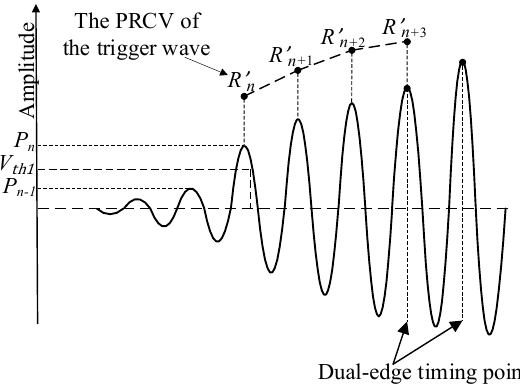
Figure 9. The PRCV of the trigger wave and the wave at the dual-edge timing point.